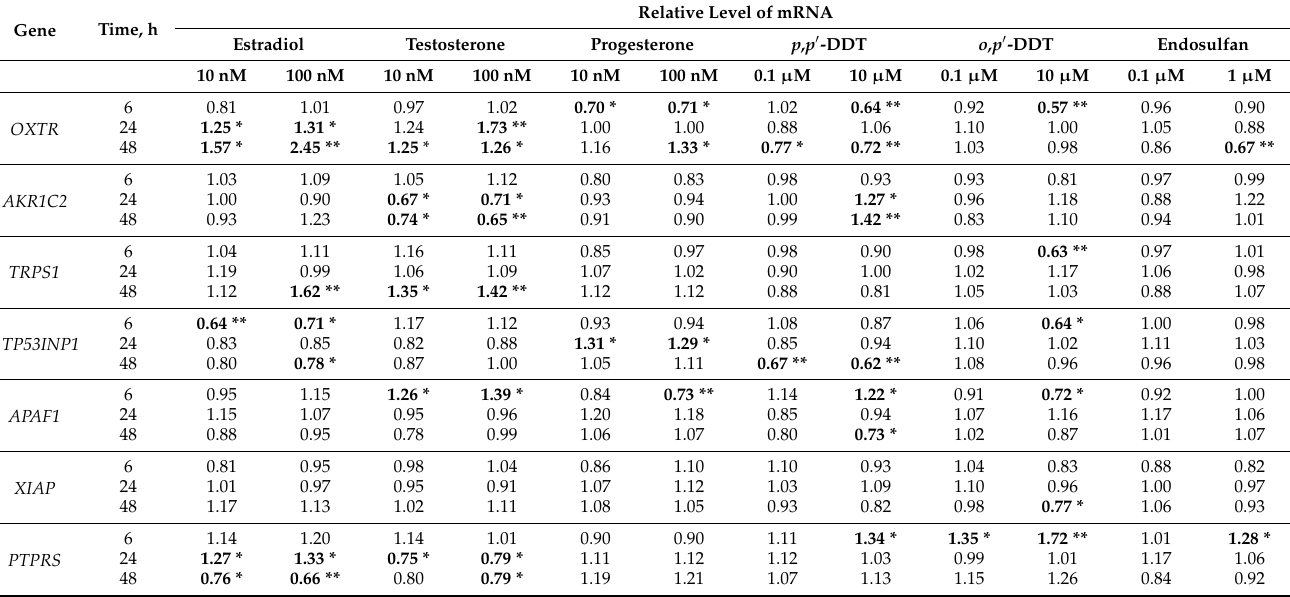
Table 9. Relative mRNA levels in MCF-7 cells exposed to estradiol, testosterone,